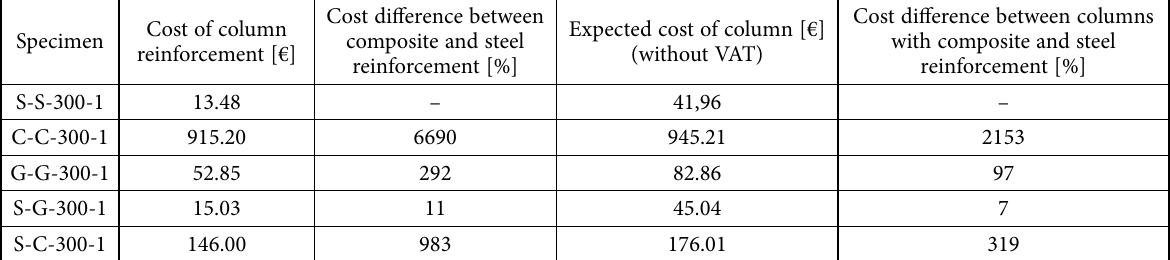
Table 5. The comparative cost analysis of annular cross-section columns with steel and composite reinforcement